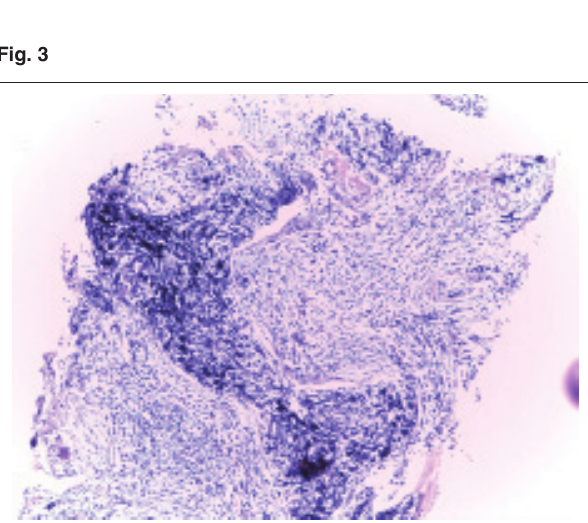
A section from needle core biopsy showing linear strip of tissue containing pleura, alveolar spaces and a dense foci carbon surrounded by fibrocollagenous tissue along with nodular aggregates of